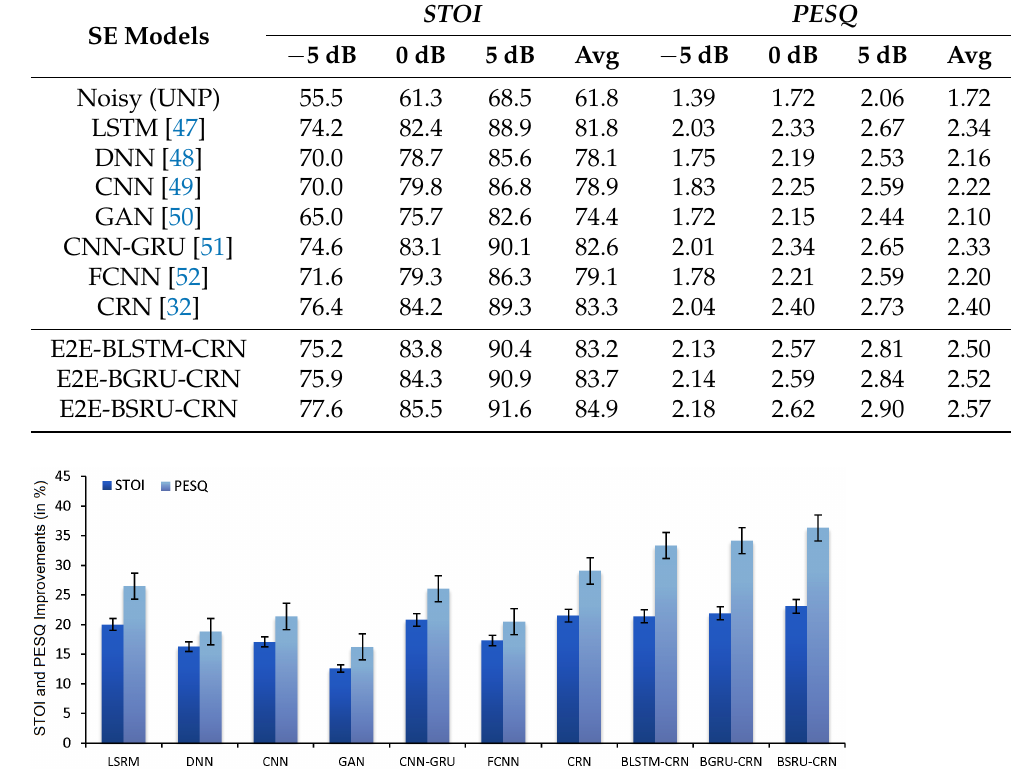
Figure 8. PESQ and STOI Percentage Improvements of All Speech Enhancement Models over the Noisy speech (Unprocessed).